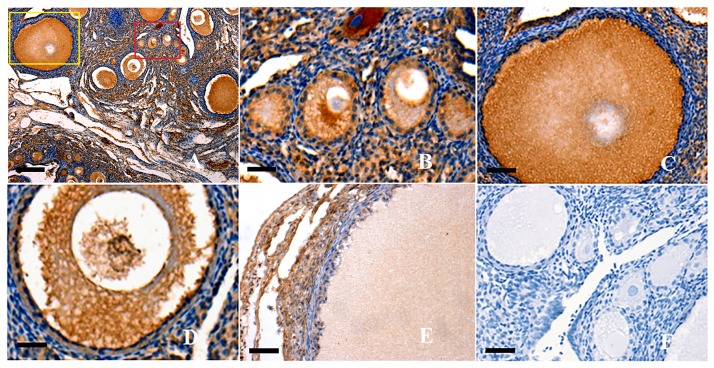
Immunohistochemical analysis of SAV1 protein expression in the ovarian follicles.Paraformaldehyde-fixed tissue sections were immunostained using anti-chicken SAV1 as described above. Panel A, strong staining is observed in all oocytes (OC) and granulosa cells (GCs) within the variously sized prehierarchical follicles (×10). Panel B, the amplified primordial follicle and primary follicle (×100), paralleling the one marked in the read box of panel A; Panel C, the amplified developing PF follicles with two or three layers of GCs (×20), paralleling the one marked in the yellow box of panel A. Panel D, the amplified small PF follicles with one or more layers of GCs (×40). Panel E, the amplified large PF follicles with more layers of GCs (×20). Panel F, one of the negative controls for SAV1, the sections were immunostained with pre-immune serum, no significant expression was detected. Negative control sections were prepared with the primary antibody pre-incubated with a blocking peptide for 1 h at room temperature and for 2 h at 4°C. Five birds were used for immunohistochemical analysis and representative microscopic fields were selected. Scale bar = 100 μm.